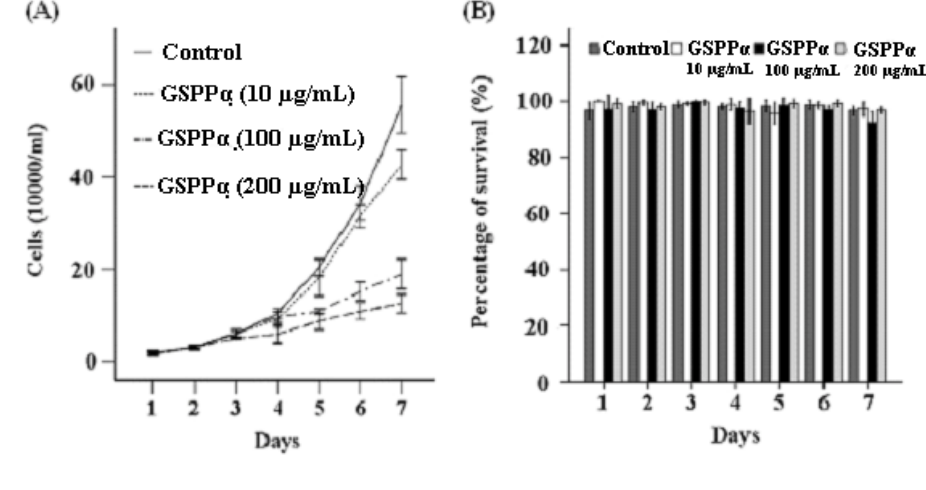
Figure 3. Effects of Gekko sulfated glycopeptides on proliferation and survival of SMMC-7721 cells. After exposure to Gekko sulfated glycopeptides, SMMC-7721 cells were collected at 30 min, then 24, 48, 72, 96, 120 and 144 h. The total cell and viable cell counts were determined by using a trypan blue exclusion assay. The growth curves of cells ( A ) and percentage of survival ( B ) were plotted. Raw data for the survival were expressed as the percentage of survival. The values represent means ± SD. GSPP α : Gekko sulfated